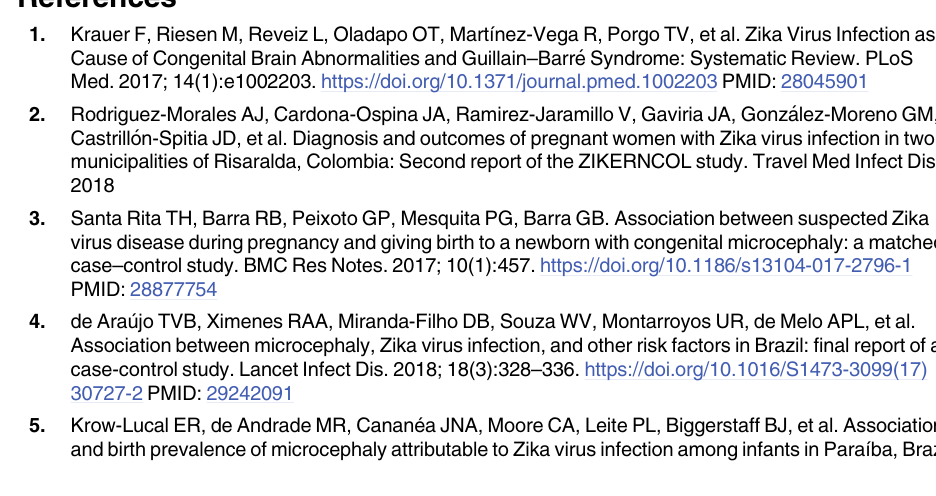
S5 Table. Summary of parameter estimates for the analysis of the second ZIKV infection incidence wave. Analysis column describes which mechanism was under investigation for that analysis; parameter column describes the parameter being estimated; values shown are the posterior mean and 95% credible